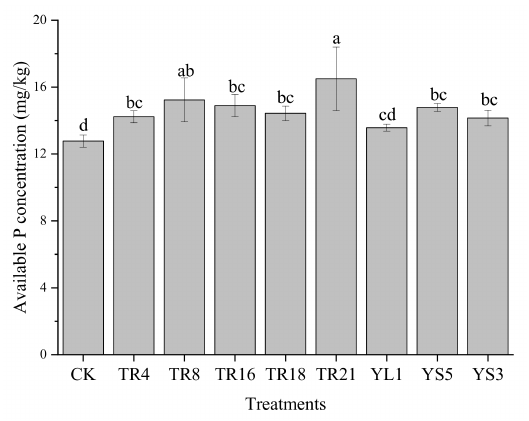
Figure 5. Available P concentration in soil with different inoculation of endophytic bacteria. The different lowercase letters in the figure indicate significant differences ( p <